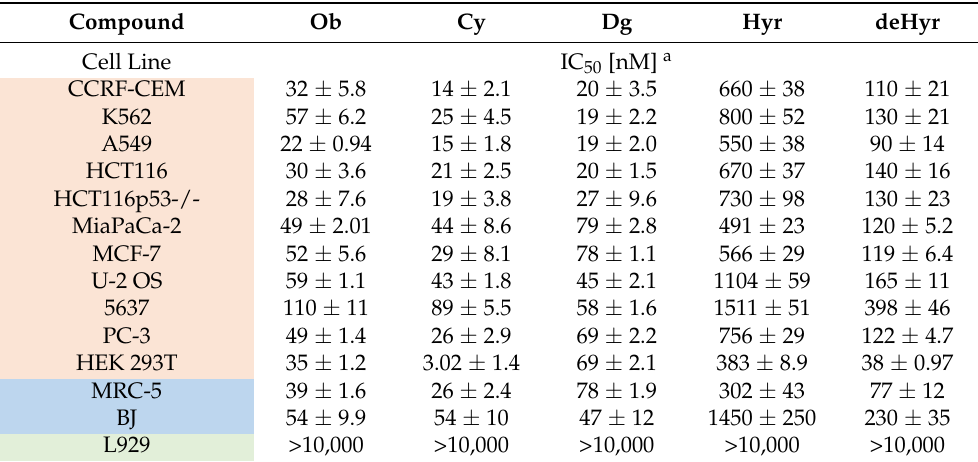
Table 2. Summary of cytotoxic activities (IC 50 , nM) of the examined cardiac glycosides: ouabain (Ob), cymarin (Cy), digitoxin (Dg), hyrcanoside (Hyr), and deglucohyrcanoside (deHyr) after 72 h of incubation with cancerous and noncancerous human and mouse